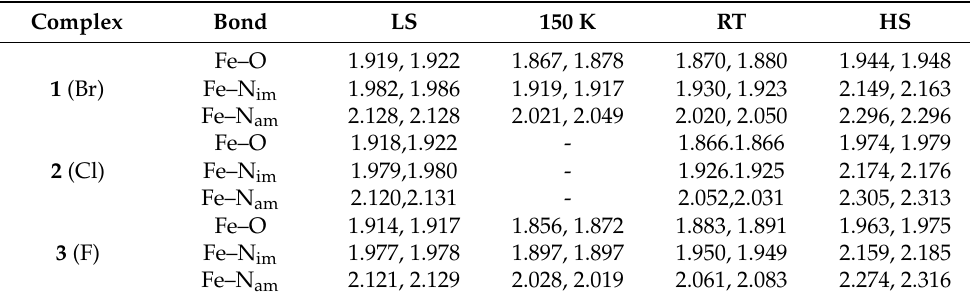
Table 4. Fe-O/N bond lengths (Å) of the DFT (ADF, B3LYP*) optimised structures (CAS models) for LS and HS states and crystallographic structures at room temperature and 150 K for complexes 1 , 2 , and 3 . Complex Bond LS 150 K